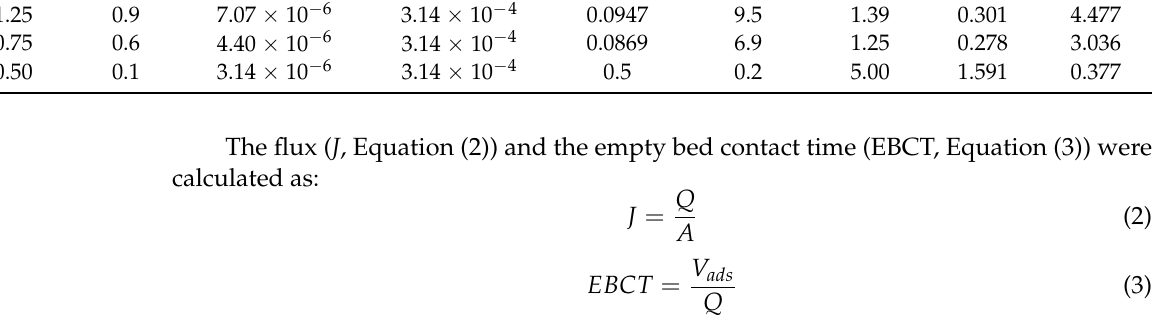
Table 3. Carbon usage rate (CUR), flux (J), and empty bed contact time (EBCT) for the different adsorption columns. M ads Column